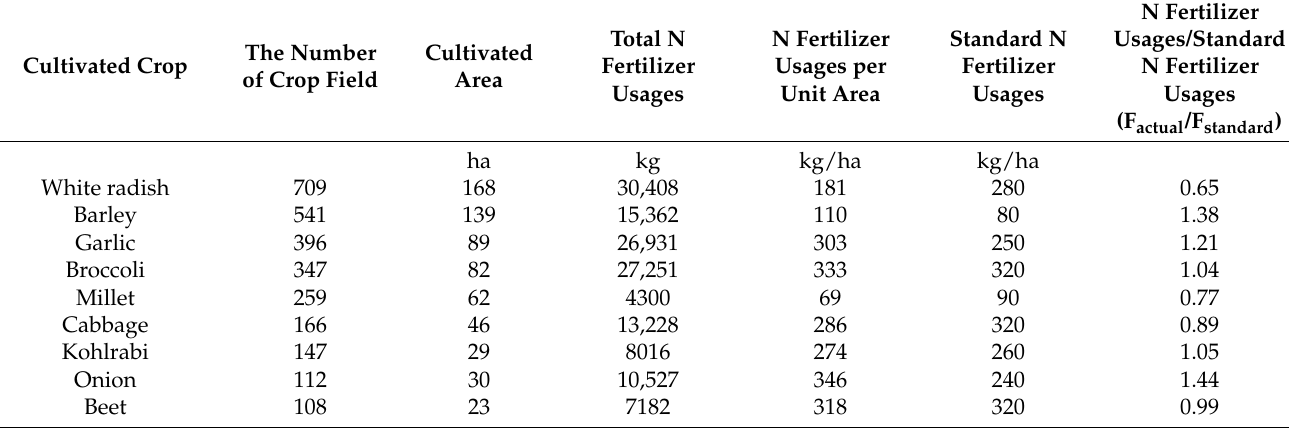
Table 1. Information on cultivated crops, fertilizer usage, and standard fertilizer use, from the survey.